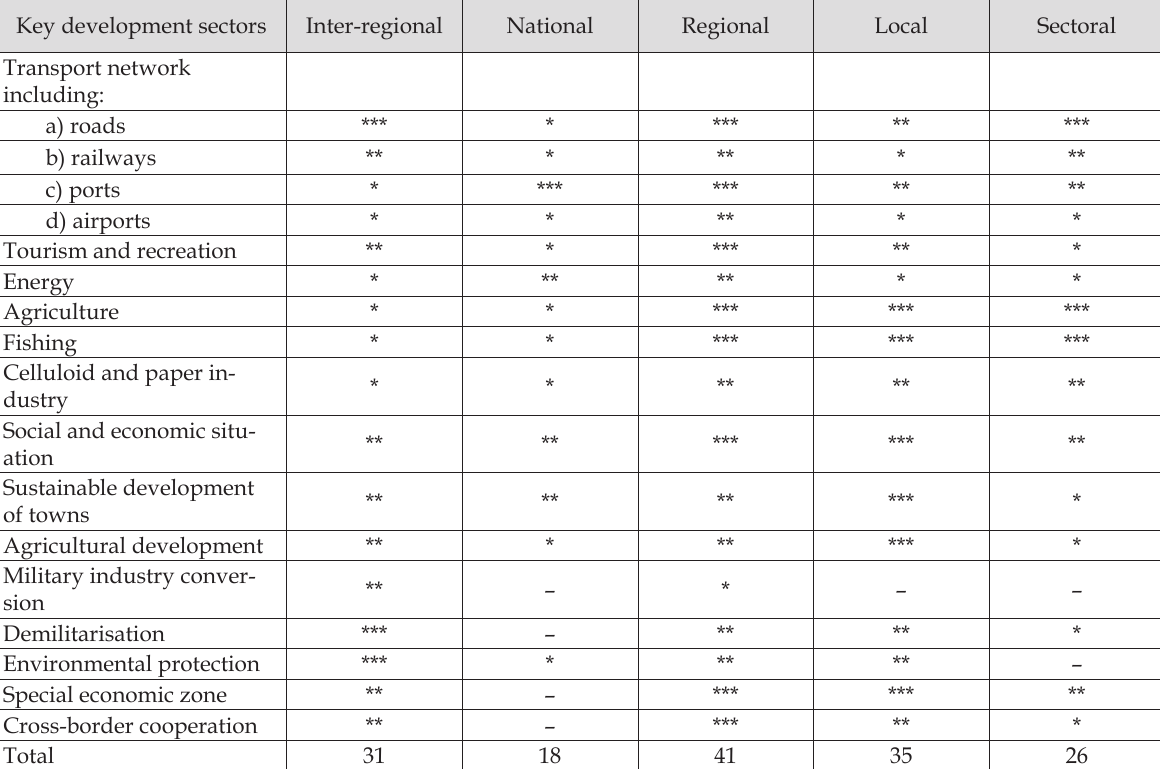
Table 3. Regional development priorities of the Kaliningrad Oblast Key development sectors